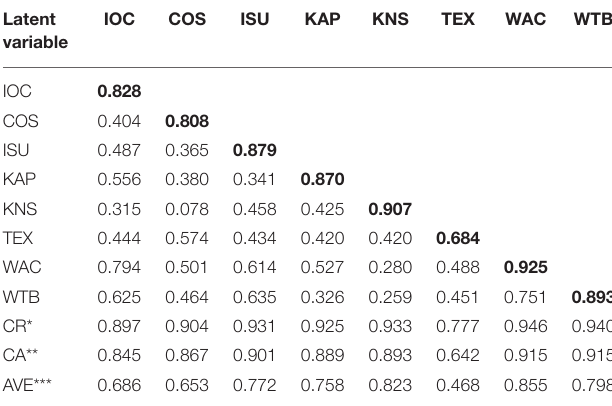
TABLE 1 | Discriminant validity of the